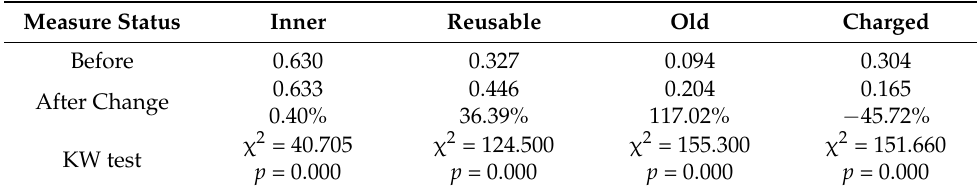
Table 1. The mean values and KW test results for the usage of different bags before and after tougher